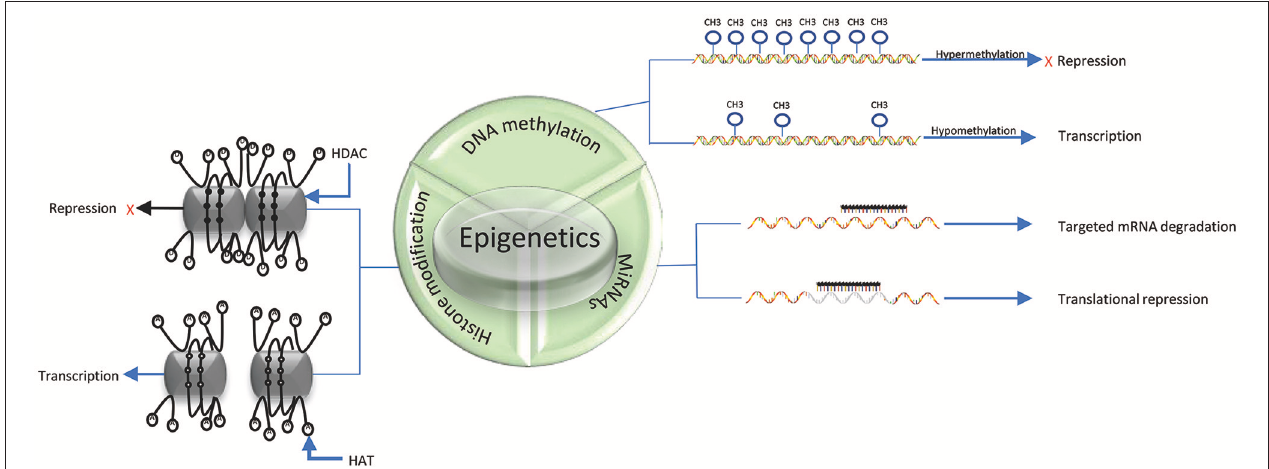
FIGURE 2 | Mechanisms of epigenetics. DNA hypermethylation leads to the repression of gene expression, while DNA hypomethylation promotes gene transcription. Histone deacetylation (D) of histone tails catalyzed by HDACs in association with DNA methylation (black solid circle) represses gene expression; Acetylation of histone tails (A) regulated by HATs in association with DNA demethylation (black hallow circle) promotes gene expression. miRNAs can suppress translation by binding to specific mRNAs. The three epigenetic modifications can interplay with each other.